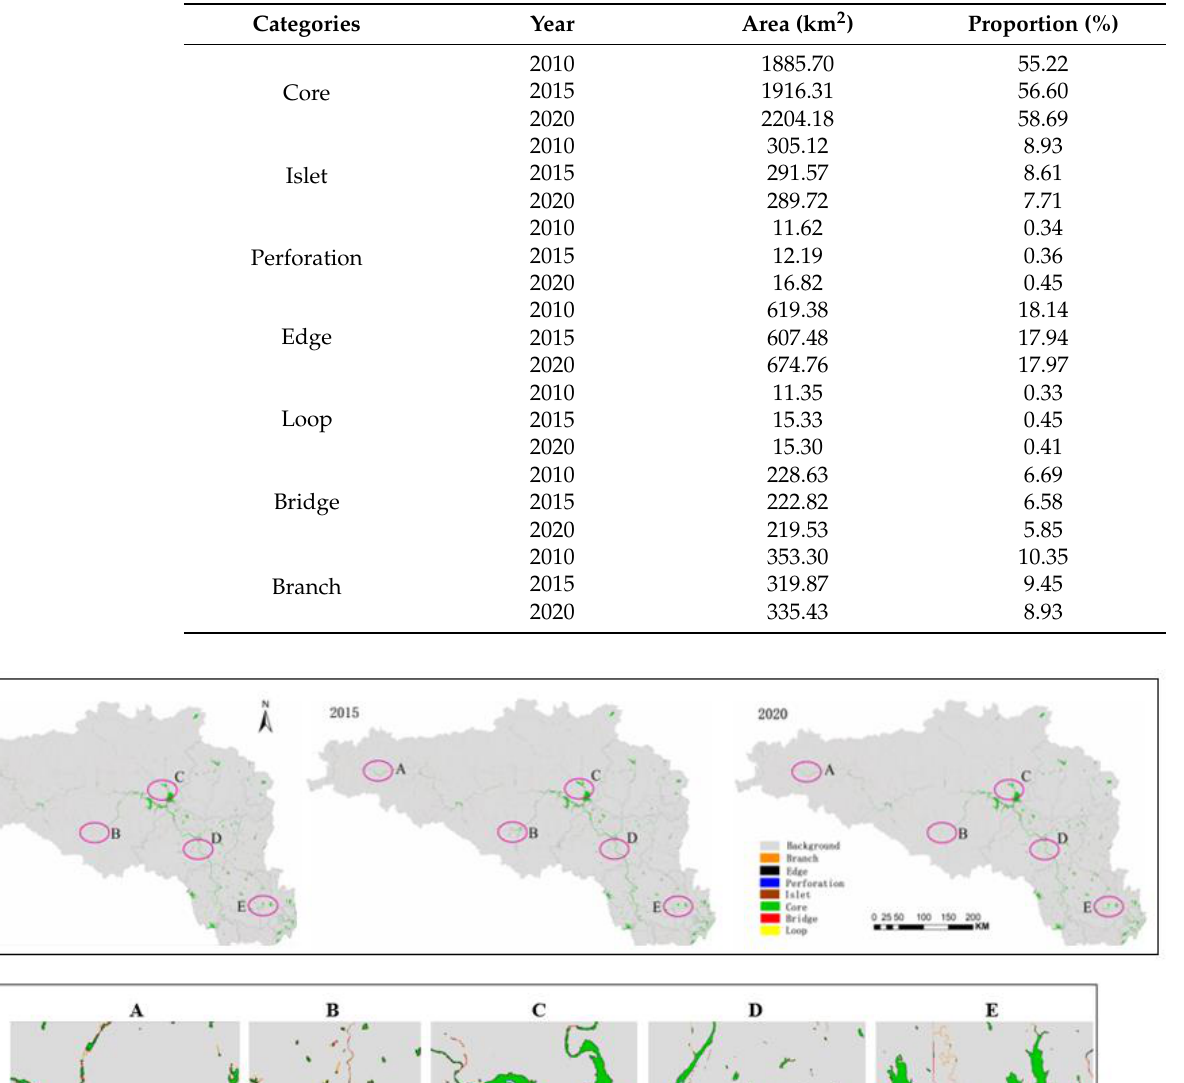
Table 3. Results of MSPA analysis of the Hanjiang Ecological Economic Zone.